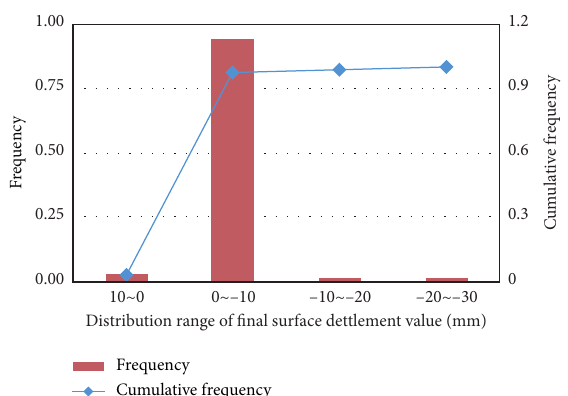
Figure 14: Histogram of frequency distribution of final surface settlement